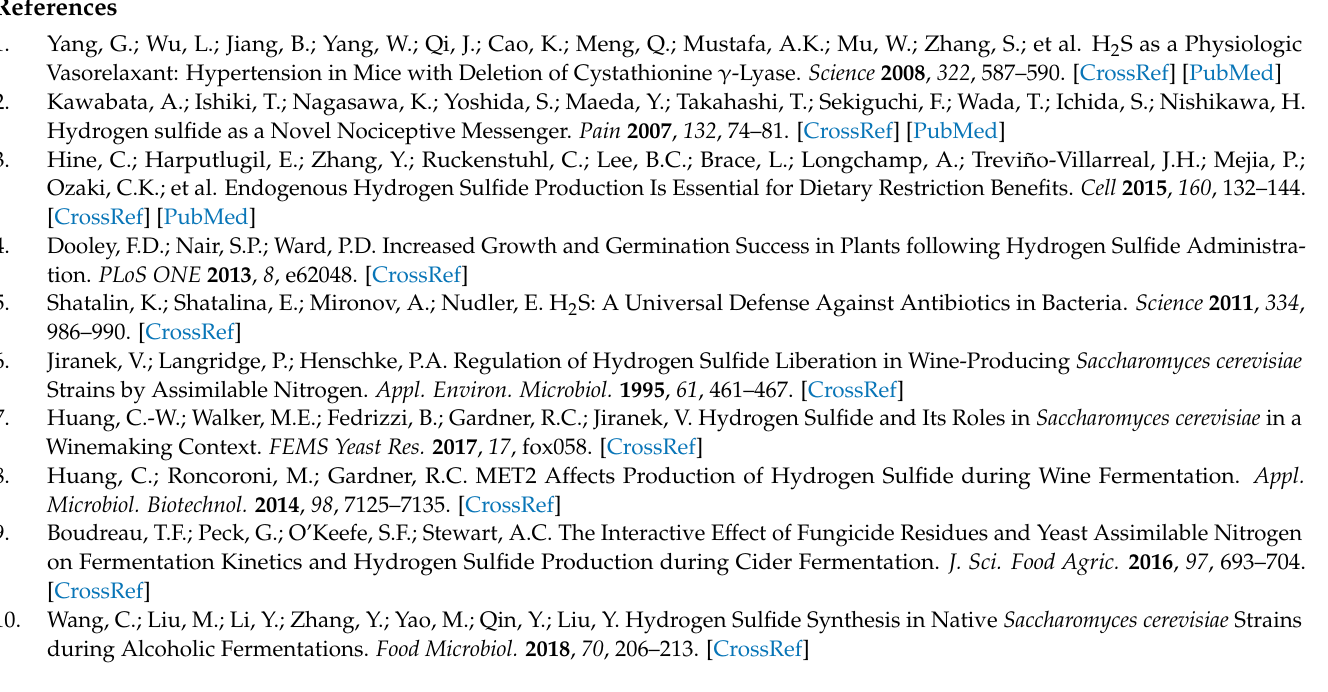
activity; Figure S2: ATP synthase alignment; Figure S3: wt , met5 ∆ met10 ∆ , and met17 ∆ strain growth curves; Table S1: Strains and oligonucleotide primers; Table S2: Mass spectrometry results; Table S3: Protein activity